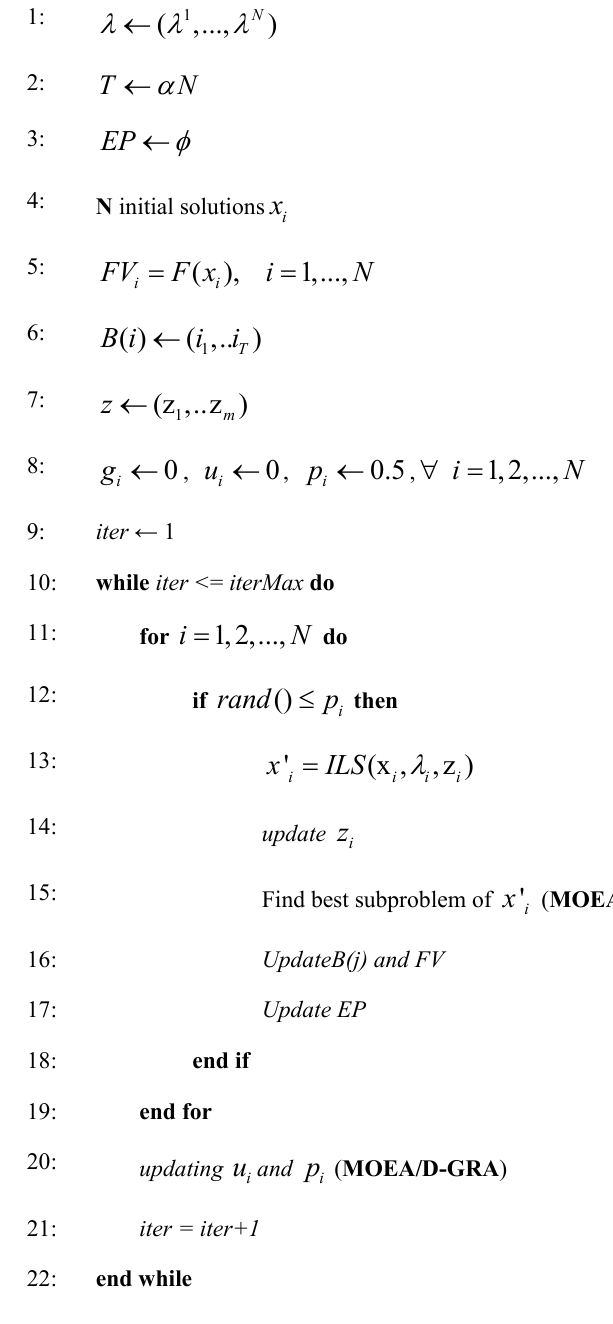
Algorithm 1 . ILS/D